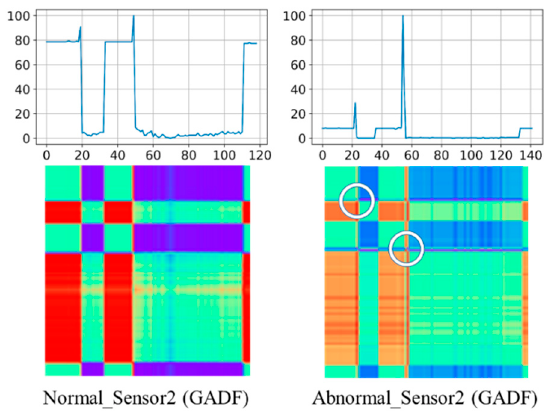
Figure 1. A Gramian Angular Difference Field (GADF) example of normal sensor and abnormal sensor in a Wafer dataset.